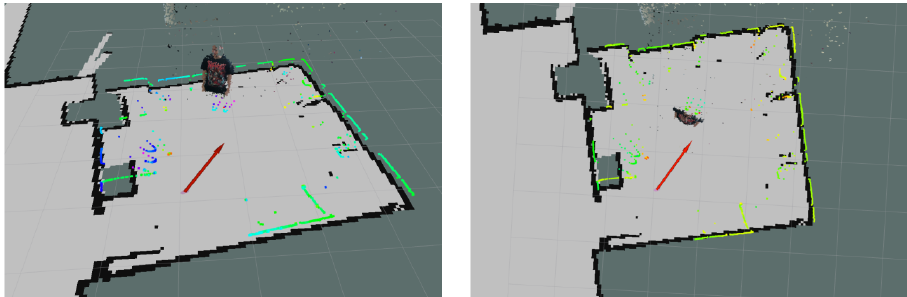
Figure 2. Side view ( left ) and top view ( right ) of aligned data from multiple sensors. Greenish dots correspond to the 2D LiDAR, and the colored point cloud corresponds to the RGBD camera. The robot pose is represented with the red arrow. The two U-shaped elements captured with the 2D LiDAR at the center of the room (person feet) are correctly aligned with the person captured in the point